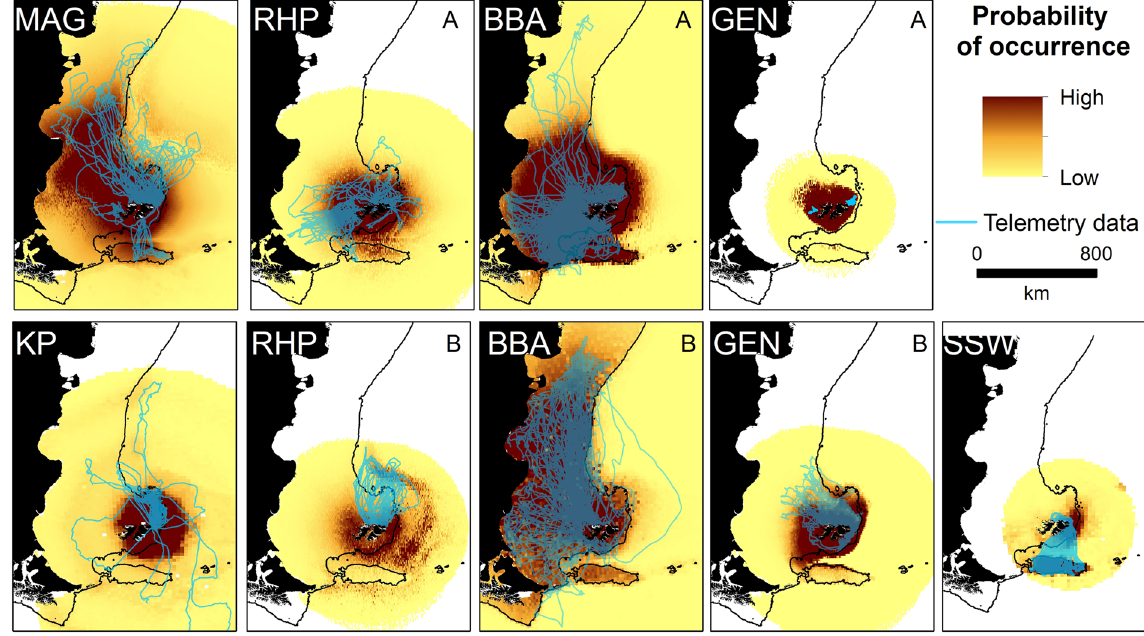
Figure 2. Seabird predicted habitat use (probability of occurrence, proportional to the likelihood of absences) at the Falkland Islands and available biotelemetry and biologging data (blue line). MAG = Magellanic penguin, KP = king penguin during, RHP = rockhopper penguin, BBA = black-browed albatross, GEN = gentoo penguin, SSW = sooty shearwater. A = Chick rearing, B = Incubation for rockhopper penguin and black- browed albatross, and A = Summer, B = Winter for gentoo penguins. See Supplementary Material Fig S3 for species predictions weighted by colony.